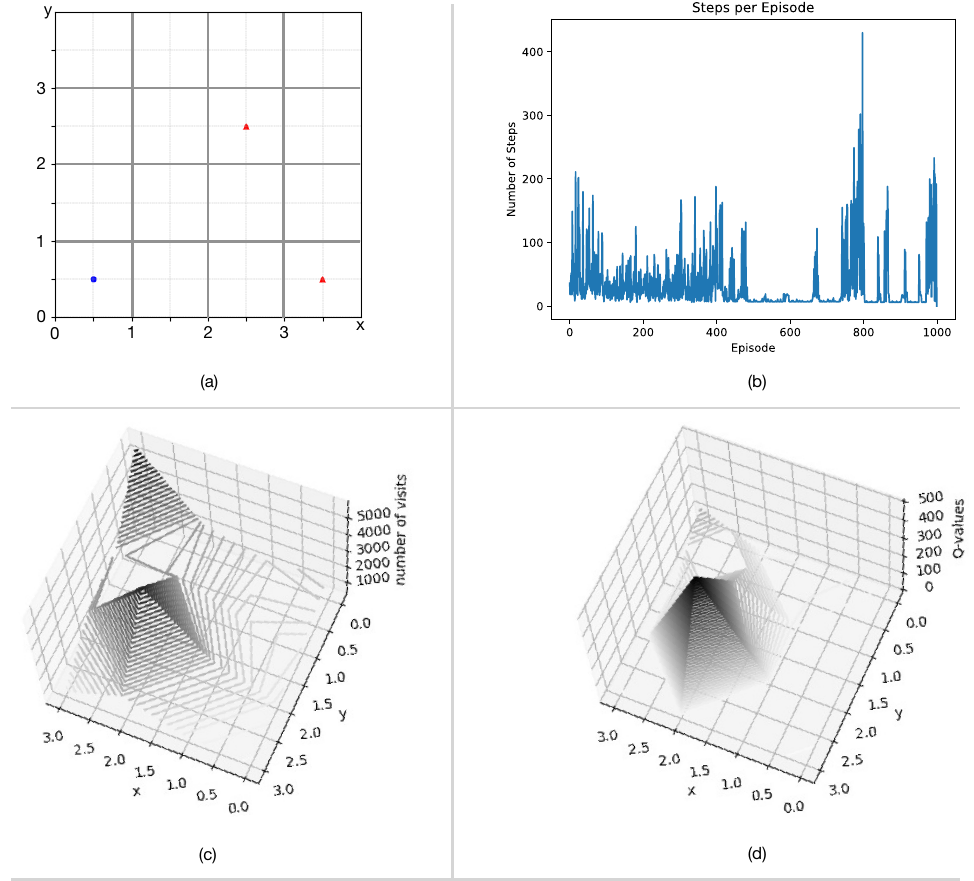
Figure 10. The single-agent, two stationary interest-points scenario. ( a ) The initial position of the agent is in cell (0,0). The interest-points are positioned in cells (2,2) and (3,0) respectively. ( b ) The number of training steps per episode does not appear to converge. ( c ) The number of visits to each cell over the entire training process. Both interest-points receive many visits. ( d ) The estimated maximum q-value of each cell. The max q-value of cell (3,0) is detrimentally small despite many visits and the interest-point